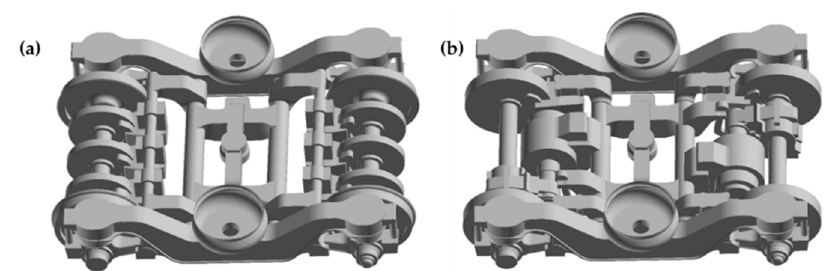
Figure 8. Simplified bogie models: ( a ) TC bogie; ( b ) MC bogie.